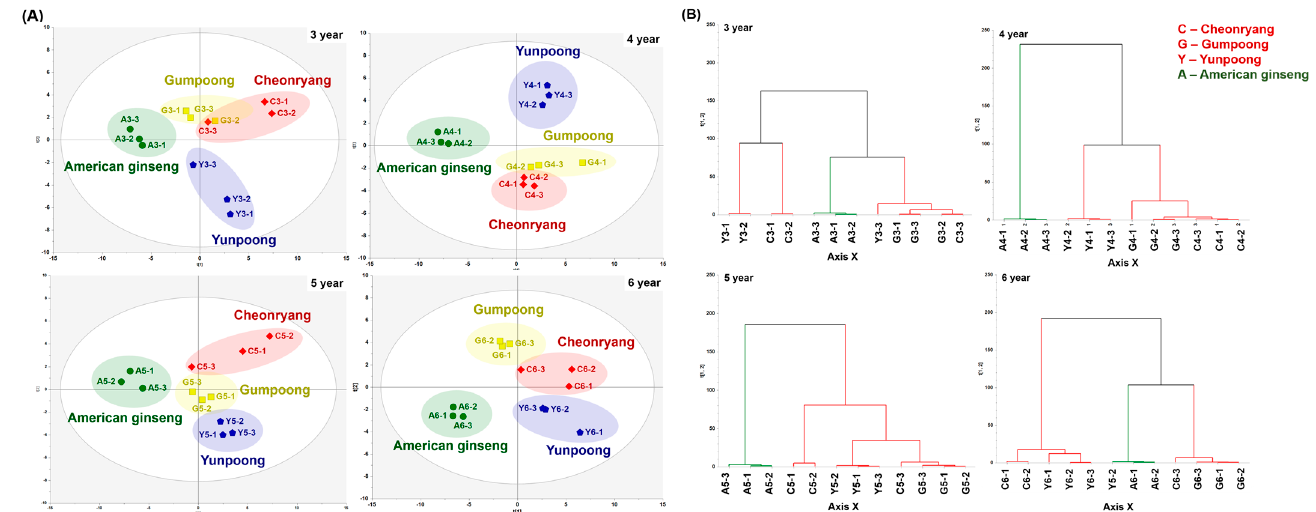
Figure 2. Discriminant analysis of four different white ginseng roots grown for 3–6 years based on volatile compound data obtained from GC ‐ MS. ( A ) PCA score plot and ( B ) HCA dendrogram.